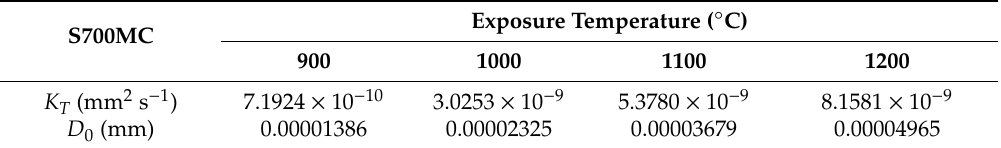
Table 3. Values of partial exponential constants K T and initial grain size D 0 for a given temperature.